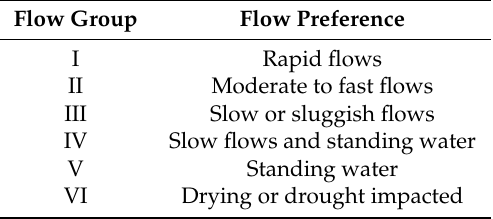
Table 1. Macroinvertebrate flow groups and associated flow preferences as defined by